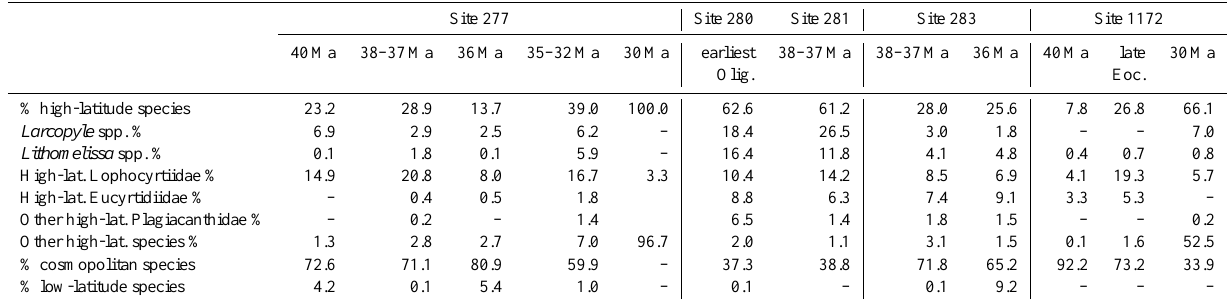
Table 2. Average of total % of high-latitude species, groups, genera and high-latitude members of families for five time slices: Middle Eocene Climatic Optimum (MECO, ∼ 40 Ma), early late Eocene/PrOM ( ∼ 38–37Ma), late Eocene warming event ( ∼ 36Ma), latest Eocene–earliest Oligocene ( ∼ 35–32Ma) and early Oligocene ( ∼